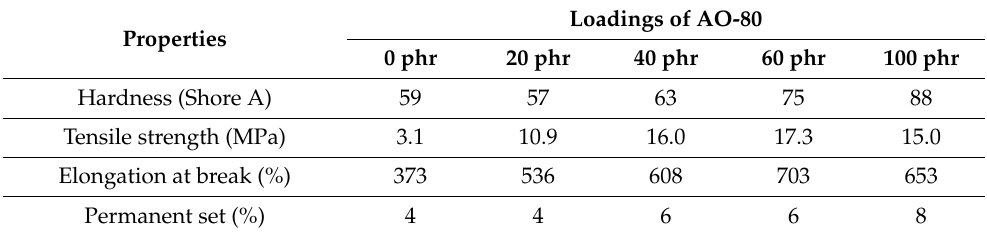
Table 1. Mechanical properties of NBR/AO-80 nanocomposites